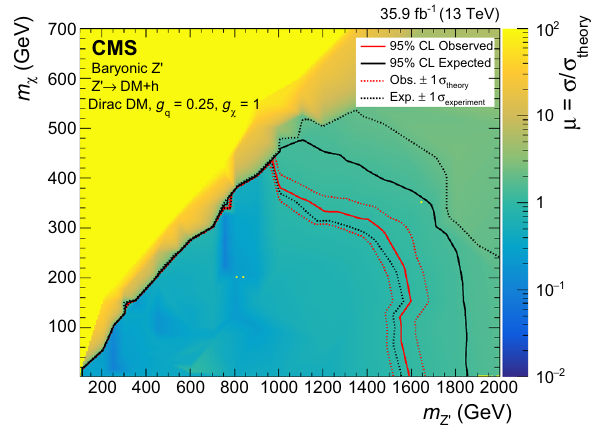
Fig. 7 Upper limits at 95% CL on the signal strength modifier, defined as μ = σ/σ theory , where σ theory is the predictedproduction cross section of DM candidates in association with a Higgs boson and σ is the upper limit on the observed cross section. Limits are shown for the baryonic Z (cid:3) model as a function of m Z (cid:3) and m χ . Mediators of up to 1.6TeV are excluded for a DM mass of 1GeV. Masses of the DM particle itself are excluded up to 430GeV for a Z (cid:3) mass of 960GeV